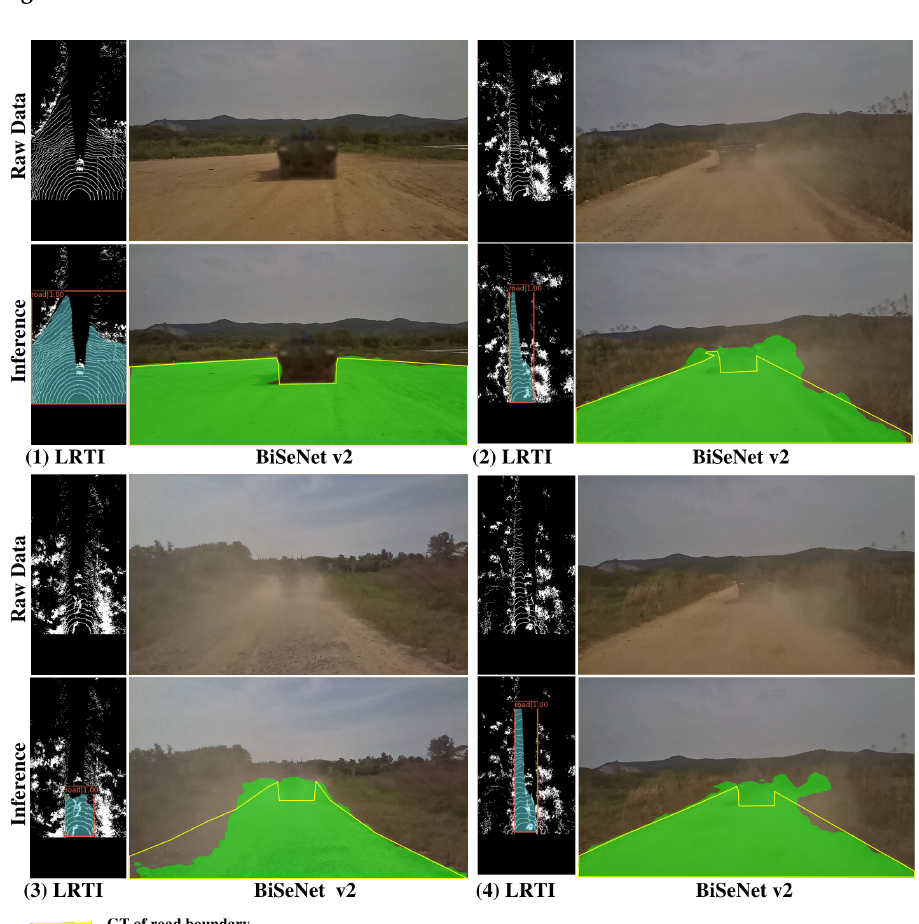
Figure 12. BiSeNet V2 [56] inference result in dust scenes. (1): No dust; (2)–(4):